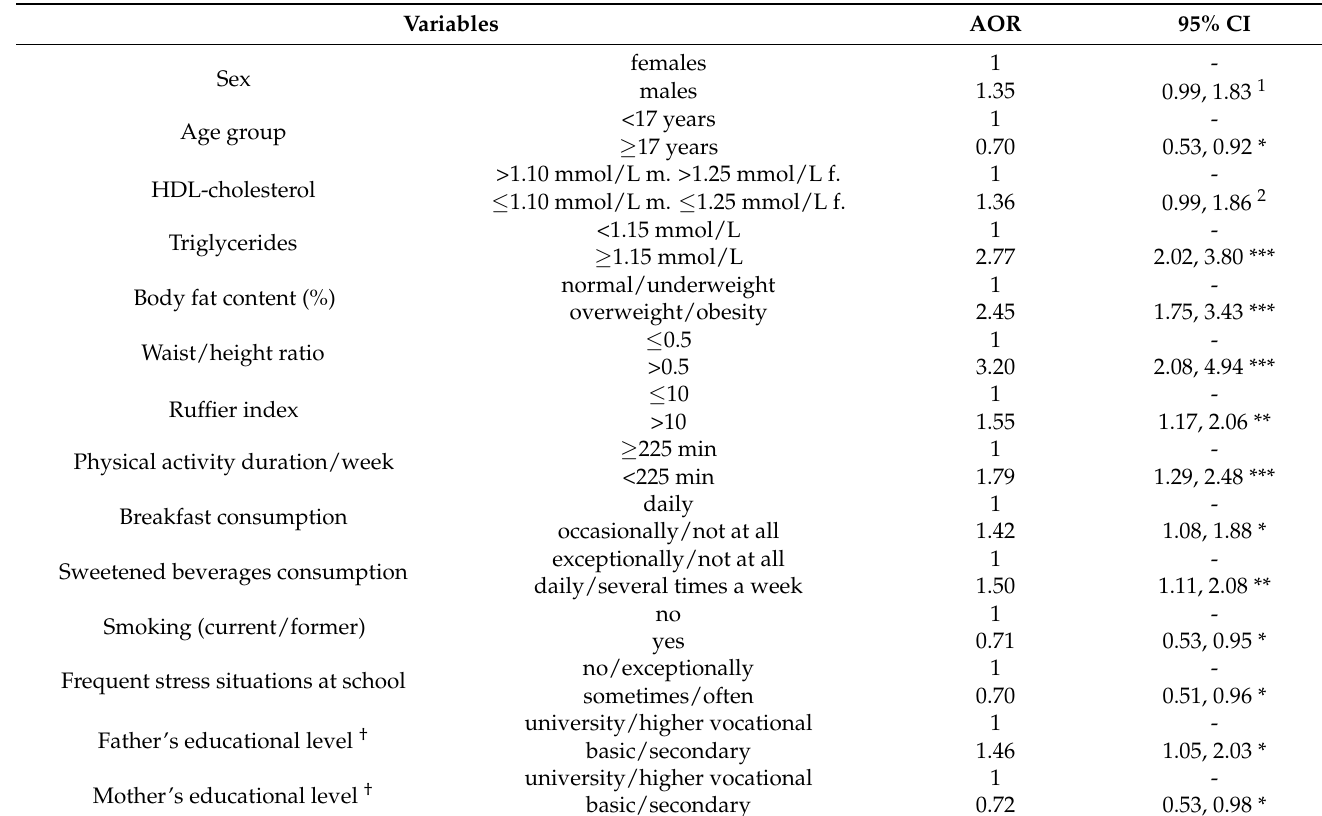
Table 6. Variables significantly associated with insulin resistance (defined according to HOMA-IR) in adolescents (n = 2629)—backward stepwise logistic regression analysis, age, and